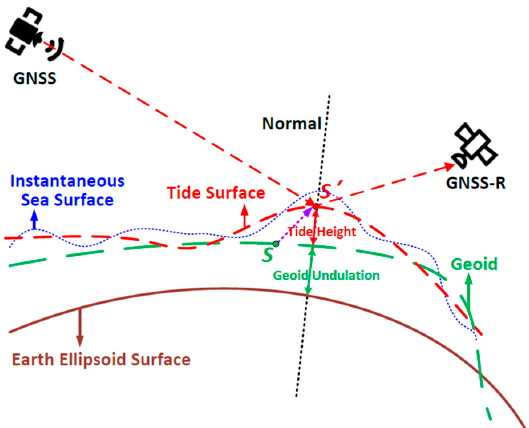
Figure 1. GNSS-R reflection reference surfaces and the corresponding specular reflection points. Where S and S’ are the specular reflection points on geoid and ocean tidal surface, respectively. The purple arrow represents the positioning correction by the ocean tidal correction positioning (OTCP) method.